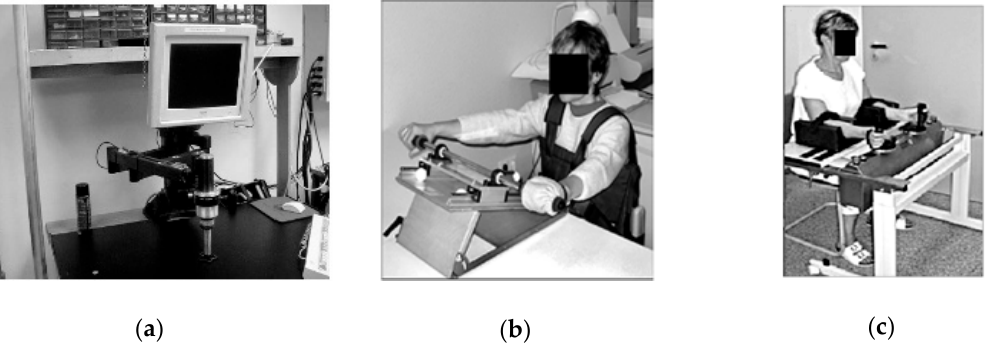
Figure 1. Examples of the first mechatronic rehabilitation supporting devices: ( a ) MIT-MANUS [4], ( b ) Nudelholz [9], ( c ) Bi-Manu-Track [9].